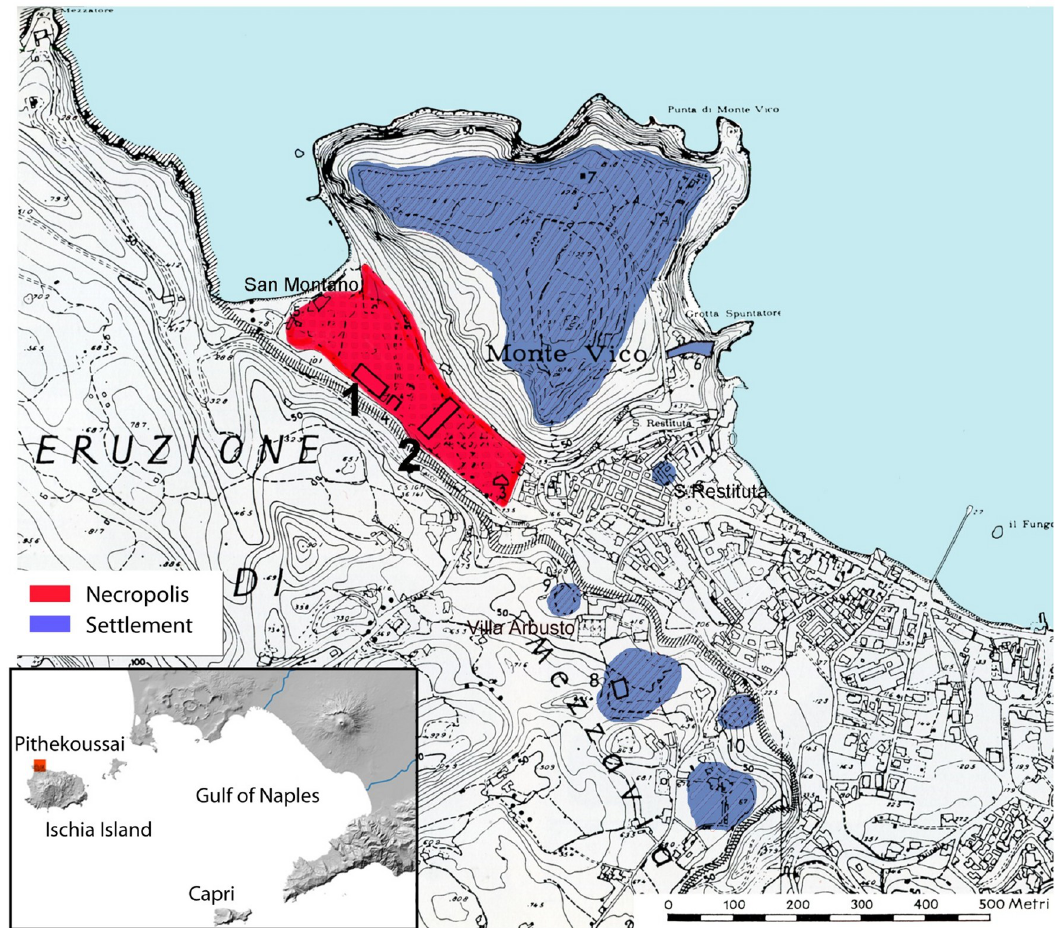
Fig 2. The location of the Pithekoussai necropolis and settlement on the Ischia Island (elaborated from [2], plan 2, by T.E. Cinquantaquattro). The geographical location of the Pithekoussai necropolis and settlement on the Ischia Island, Gulf of Naples (Campania, South of Italy). In red, the two different batches of the necropolis excavations: (1) Pithekoussai I (Buchner’s excavations 1952–1961); (2) Pithekoussai II (Buchner’s excavations 1965–1982). In blue, the settlement areas, located in the present-day town of Lacco Ameno, on Monte Vico, and the surrounding